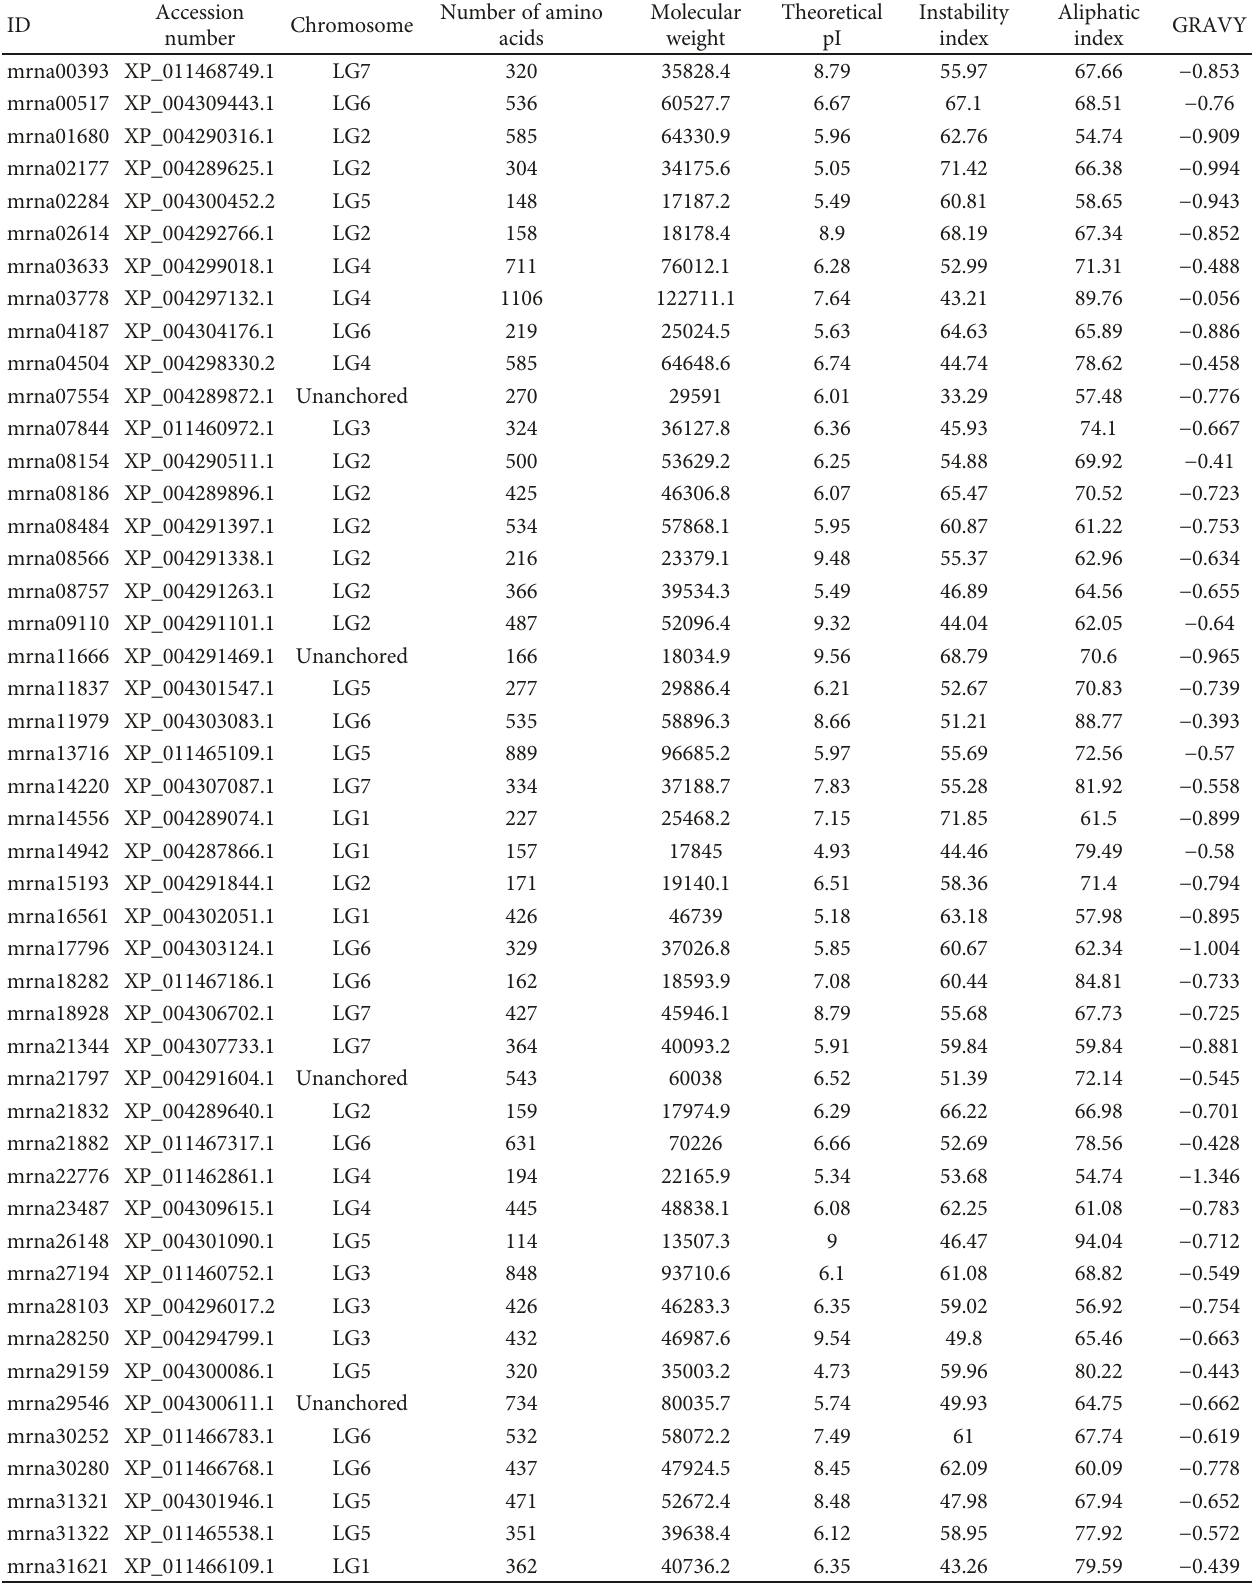
Table 1: bZIP genes identi fi ed in strawberry and their detailed